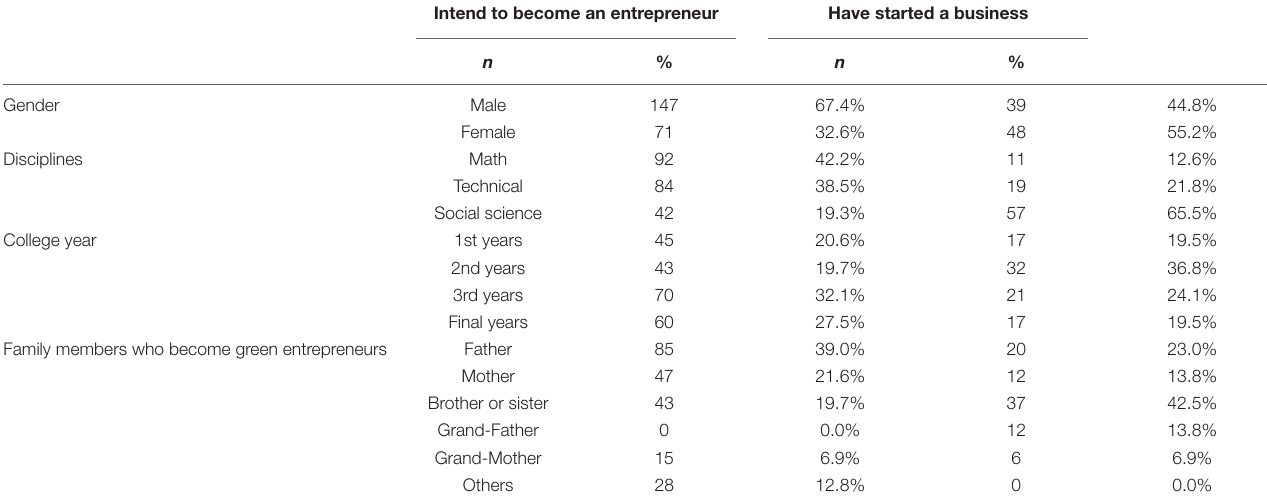
TABLE 2 | Cross-tabulation of student